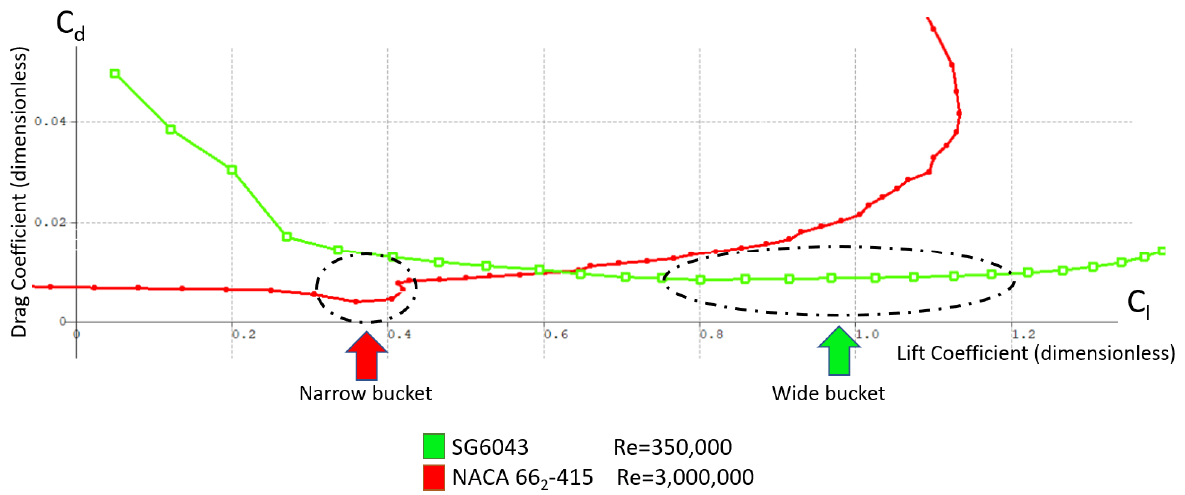
Figure 6. An example of the outspreaded bucket of a low Reynolds number airfoil (SG6043) operating at Re = 350,000, in contrast with the narrow bucket of a NACA 66 2 -415 operating at Re = 3,000,000.